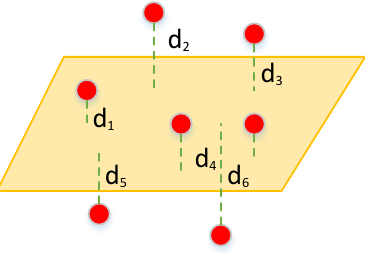
Figure 4. Residual feature estimation of voxel.